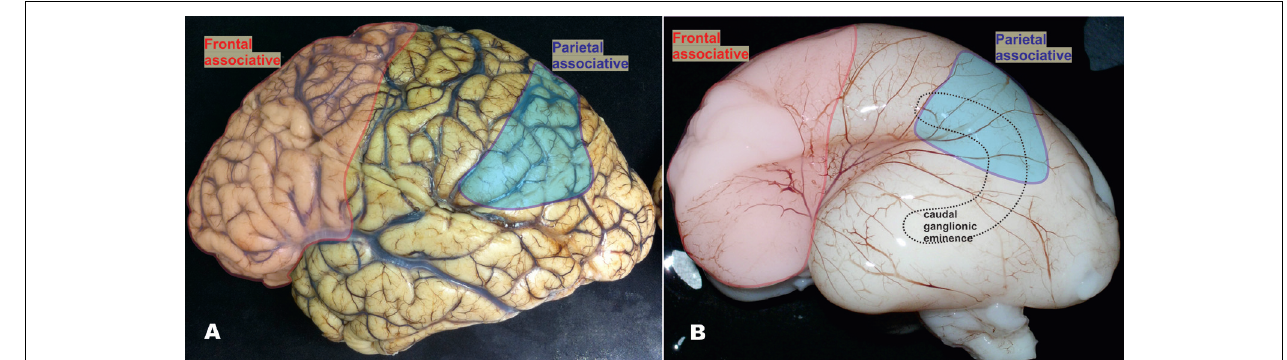
located in the frontal lobe. (B) The proportions in the size of higher order associative cortices are already established around mid-gestation. In the recent study, Ma etal. (2013) concluded that vast majority of calretinin neurons in human originate from the caudal ganglionic eminence (CGE, dashed line showed a contour of its position) and that there is no abundant production of GABAergic neurons in the pallial proliferative zones as it was suggested before (Letinic etal., 2002).The anatomical relations between anteriorly located prefrontal cortex (that comprises almost half of cortical calretinin neurons) and postero-laterally located CGE (as a main source of calretinin neurons) do not concur with this presumption (see Figure 5B ).We suggest that presumption of Ma etal. (2013) can be correct in humans for all cortical regions only during early fetal stage, and later on for the all lobes excluding frontal cortex (Al-Jaberi etal.,